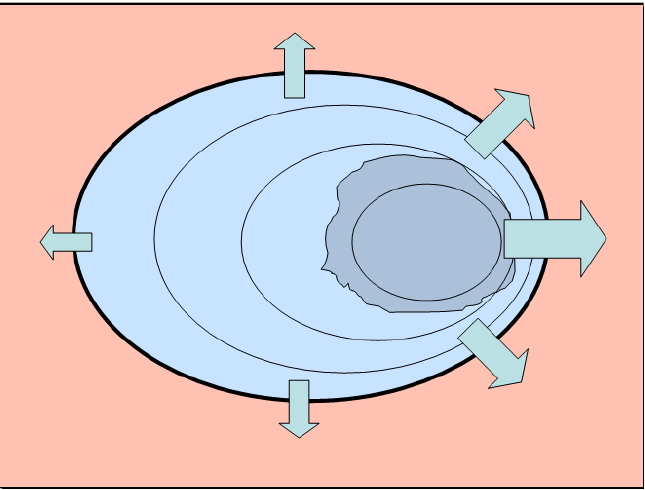
Figure 3. Schematic of the gust front modeling